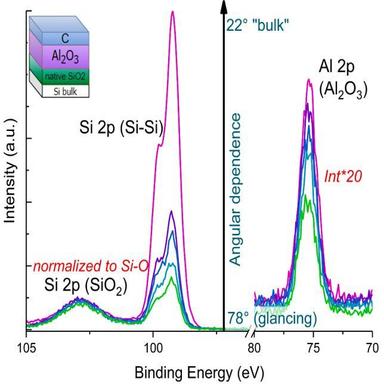
pARXPS data of an ultrathin Al2O3 sample with carbon contamination for Si 2p (left panel) and Al 2p (right panel). The violet line is from spectra recorded at the glancing emission angle, while the green and blue are spectra recorded from smaller angles which probe the bulk of the sample. The Al 2p spectrum has been increased by a factor of 20 for visual purposes. (For interpretation of the references to colour in this figure legend, the reader is referred to the web version of this article.)